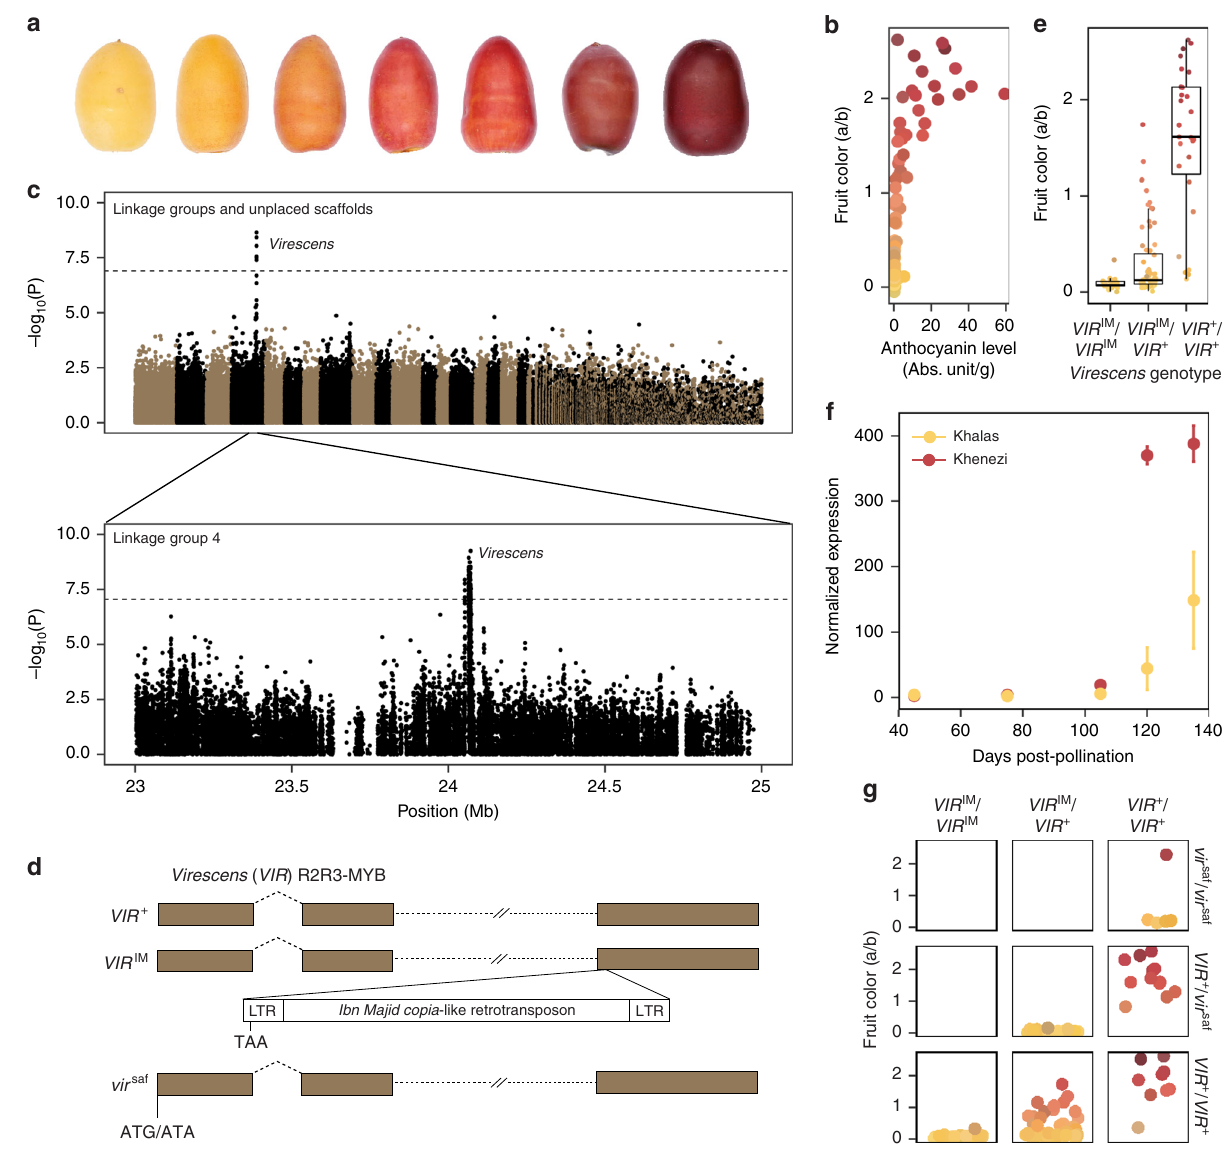
Fig. 3 The genetics of fruit color variation in date palms. a Color variation in khalal stage fruits among date palm varieties. b Fruit color measured by a color index ( a , b ) as a function of anthocyanin level with points colored according to the RGB score of the fruit color. Each point represents the average of